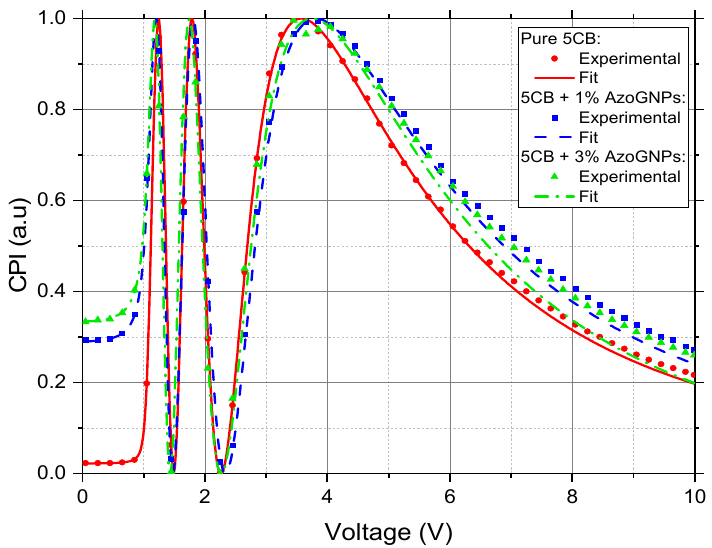
Figure 2. CPI measurements of pure and AzoGNP-doped 5CB under light illumination at 642 nm and a frequency of an applied electric field of 10 kHz. Experimental data are represented by symbols, the OMPA fits by lines. Table 1. Elastic constants and rotational viscosity of pure and nanoparticle-doped E7, 5CB and LC18523 obtained through OMPA fitting. The changes of the dielectric anisotropy through doping are also shown: Δε decreased with the addition of AzoGNPs but increased with ferroelectric nanoparticles. The errors on the OMPA fits were studied previously for elastic constants [40] and are estimated to be approximately 1% for K 1 and 2% for K 3 . The same has been carried out for viscosity measurements [38], and the error was estimated in the range of 1%.